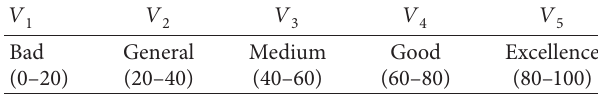
Table 2: Road characteristics evaluation set.